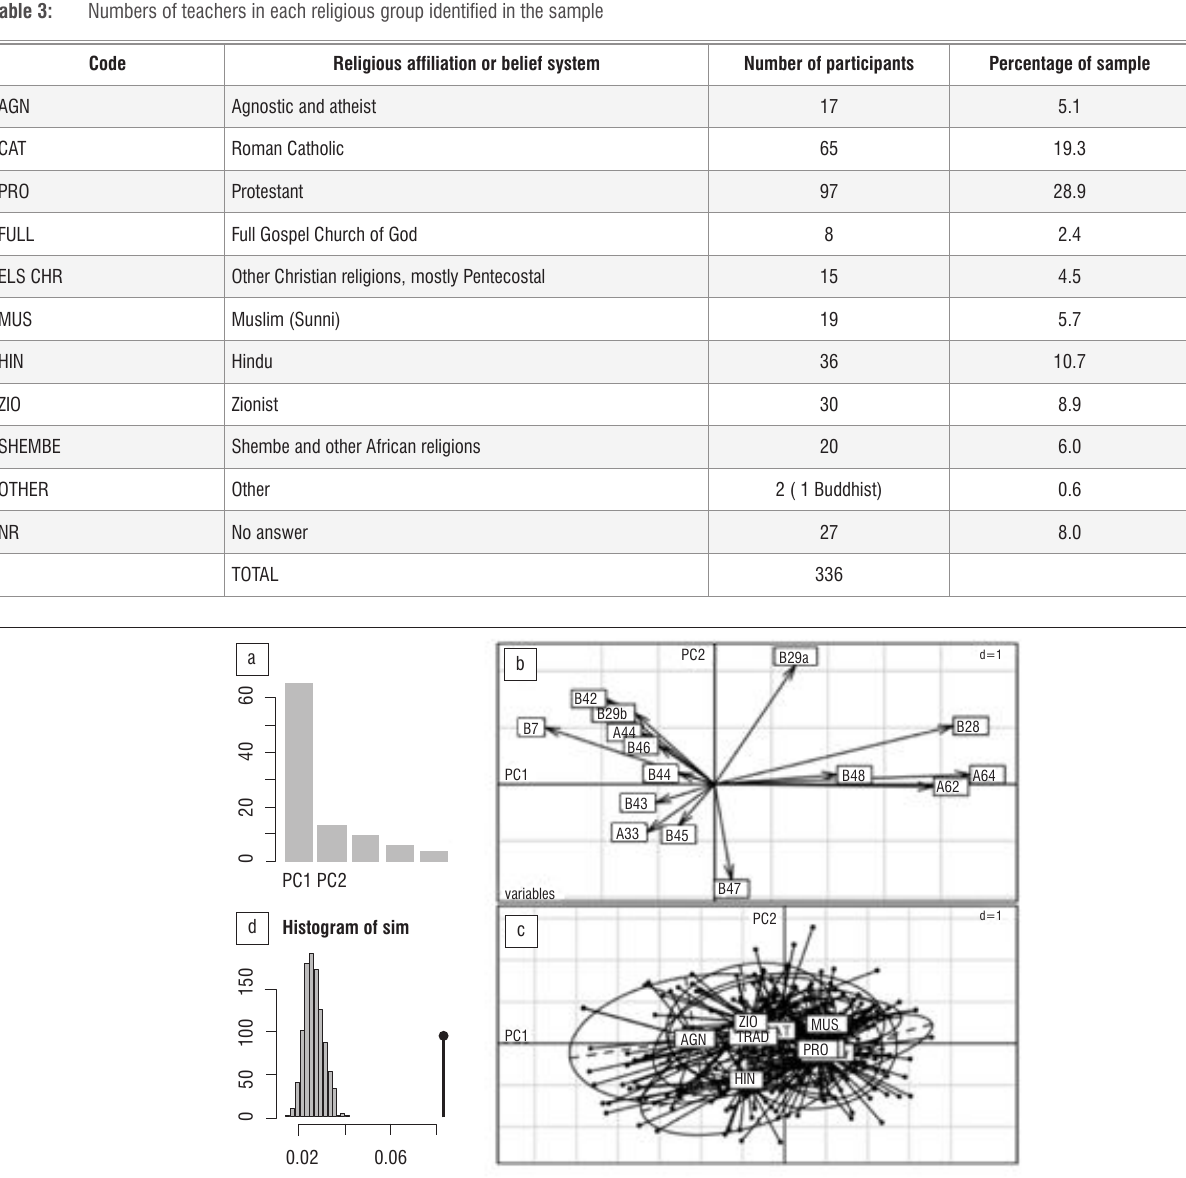
Figure 1: Between-class analysis differentiating the groups of teachers (according to religious affiliation) based on the 15 questions related to evolution. (a) Contribution of each principal component to the total variance: the first principal component (PC1) accounts for more than 65% of the total variance; the second (PC2) accounts for 12%. Subsequent components are considered to be background noise. (b) Loading of answers to the 15 questions (evolution variables) on PC1 (horizontal axis) and PC2 (vertical axis). The length of each arrow indicates the loading of each question on PC1 and PC2. (c) Each point summarises a teacher’s answers to the 15 questions, and is related to the group centroid for each religious affiliation. Each ellipse encompasses two-thirds of the teachers in a religious group. (Figure 2 presents these results in simplified and enlarged format.). (d) Histogram of simulations: Results of a randomisation test (Monte Carlo type) generated from 1000 iterations, randomly assigning a religious affiliation to each teacher. The observed variance (to the right) is distinct from random, showing that the results in Figure 1c) are not random ( p